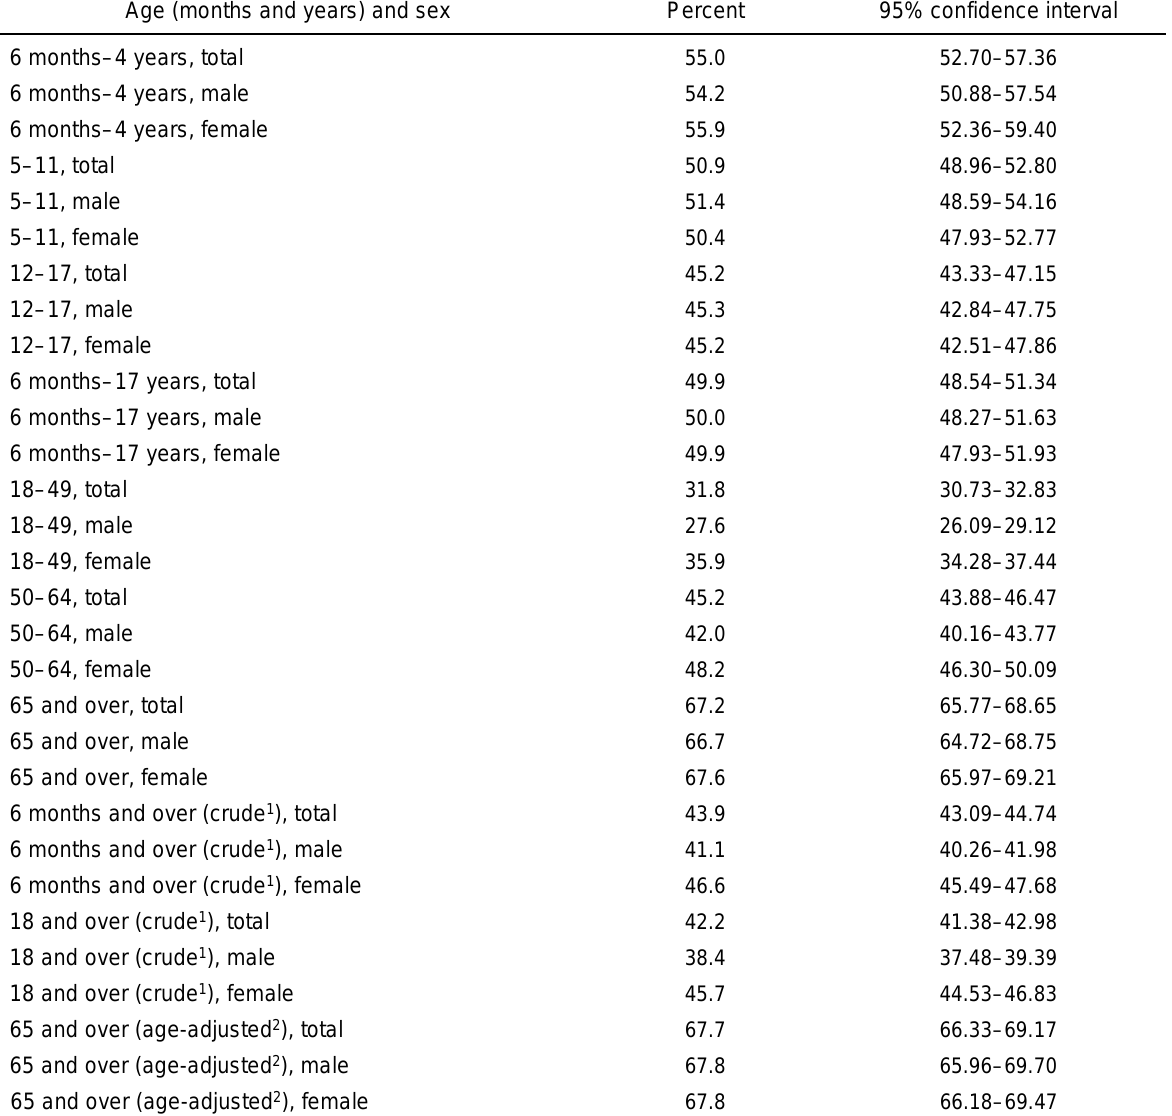
Data table for Figure 4.2. Percentage of persons who received an influenza vaccination during the past 12 months, by age group and sex: United States, 2016 Age (months and years) and sex